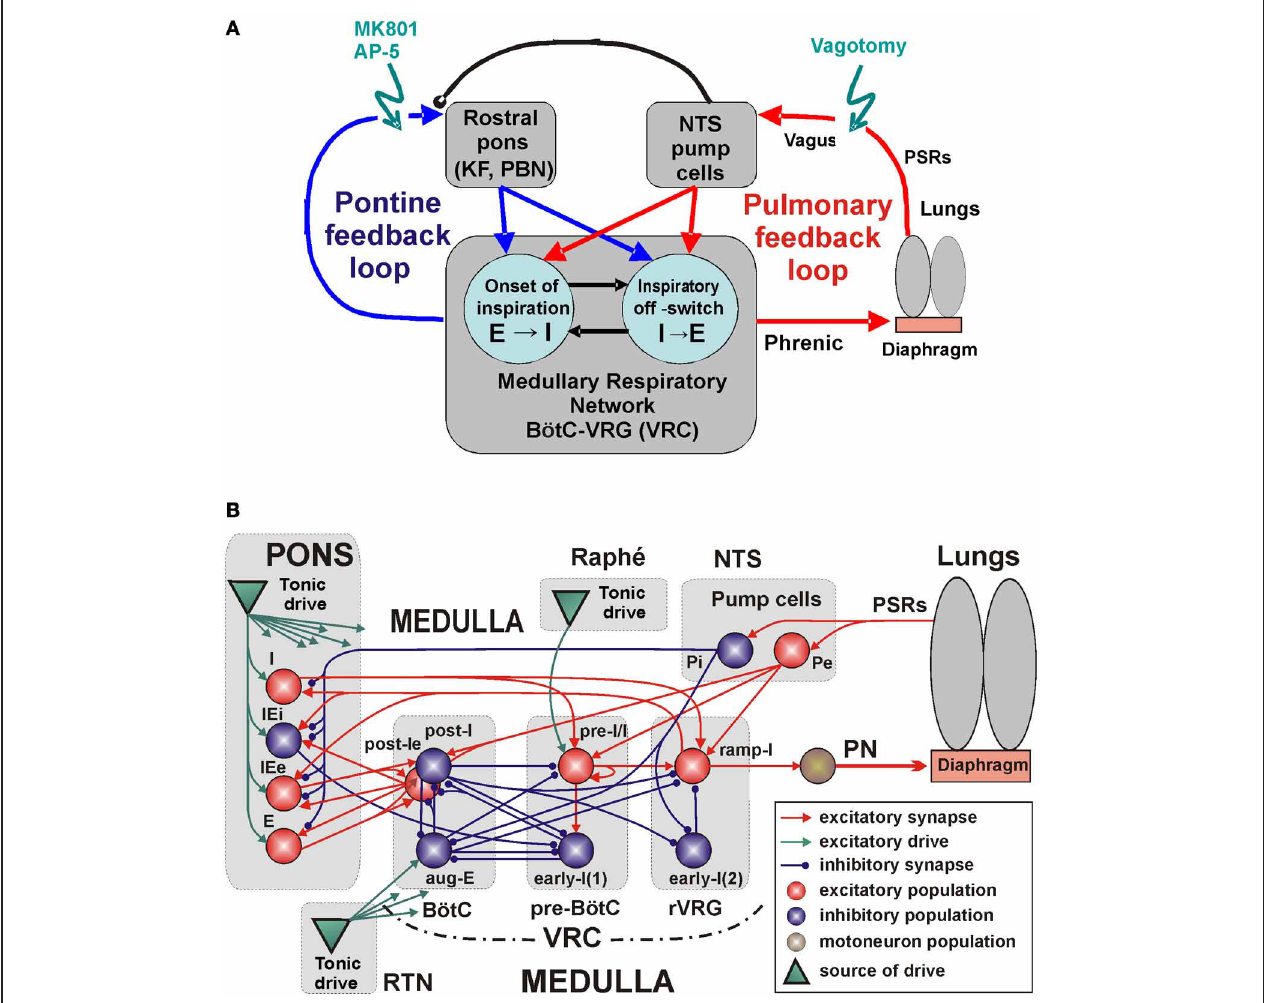
FIGURE 1 | The medullary respiratory network with pulmonary and pontine feedbacks. (A) A general schematic diagram representing the respiratory network with two interacting feedback. See text for details. (B) The detailing model schematic showing interactions between different populations of respiratory neurons within major brainstem compartments involved in the control of breathing (pons, BötC, pre-BötC, and rVRG) and the organization of pulmonary and pontine feedbacks. Each neural population (shown as a sphere) consists of 50 single-compartment neurons described in the Hodgkin-Huxley style. The model includes 3 sources of tonic excitatory drive located in the pons, RTN, and raphé—all shown as green triangles. These drives, project to multiple neural